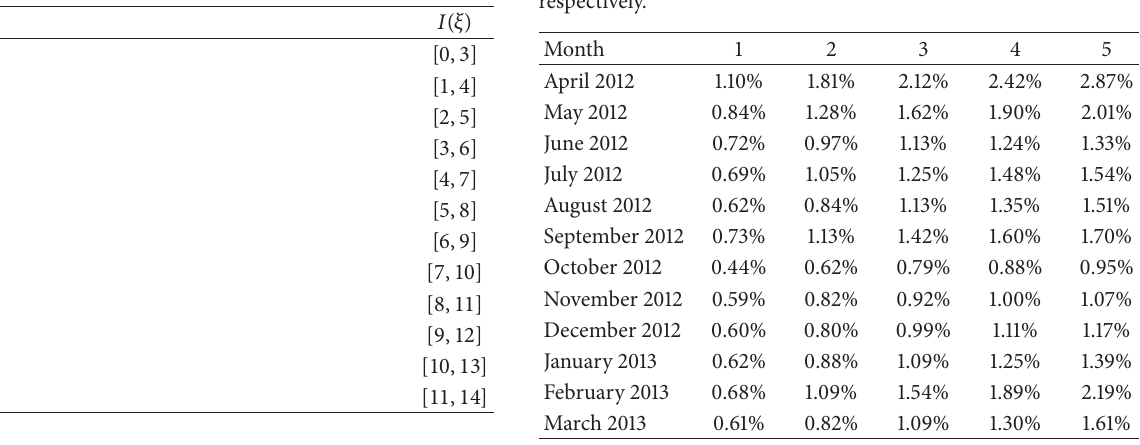
Table 1: In the first column, we have the months of electricity supply of the peak contracts considered, while in the second one we have the interval 𝐼(𝜉) relative to each contract. Note that a contract traded for 3 months is integrated in an interval of length 3 .